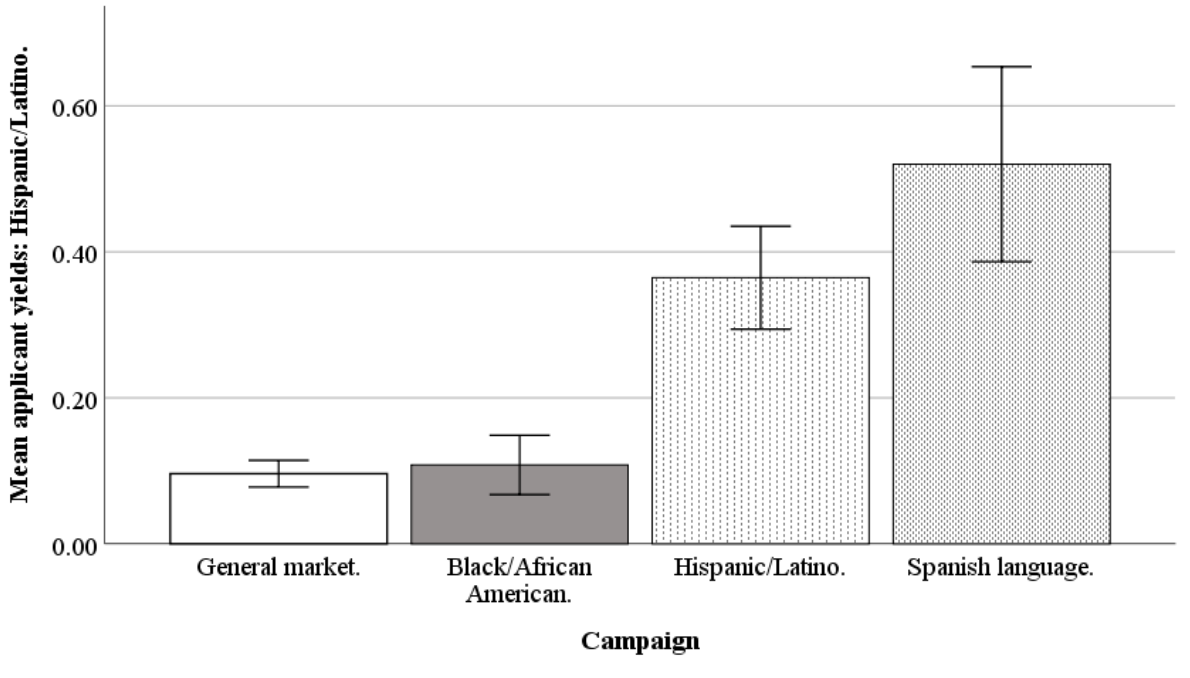
Figure 6. Mean applicant yields of Hispanics/Latinos for Facebook advertising campaigns.